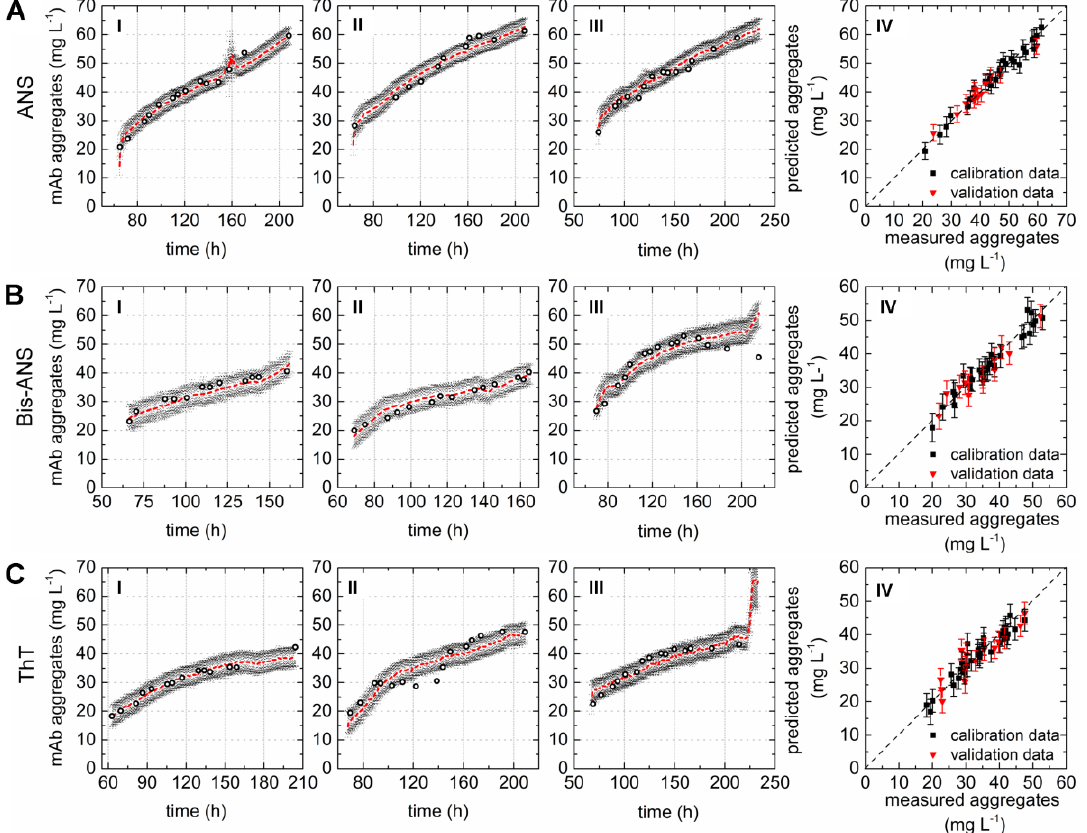
Figure 3. Correlation plots as a practical test by comparing offline values and values predicted based on the PLSR models calculated with the data recorded during three fed-batch cultivations ( I – III ) containing ( A ) 100 µ mol · L − 1 ANS; ( B ) 2 µ mol · L − 1 Bis-ANS; and ( C ) 2 µ mol · L − 1 ThT. Offline measured measurements (circles), predicted values (red), and corresponding confidence limits of the prediction based on the calculated errors (black). Plot IV ( A – C ) shows the predicted versus reference plots of the resulting PLSR models.